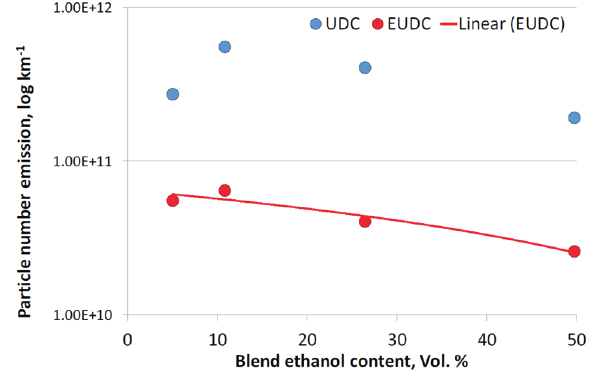
Fig. 10. Vehicle PN emissions on UDC and EUDC cycle [9]